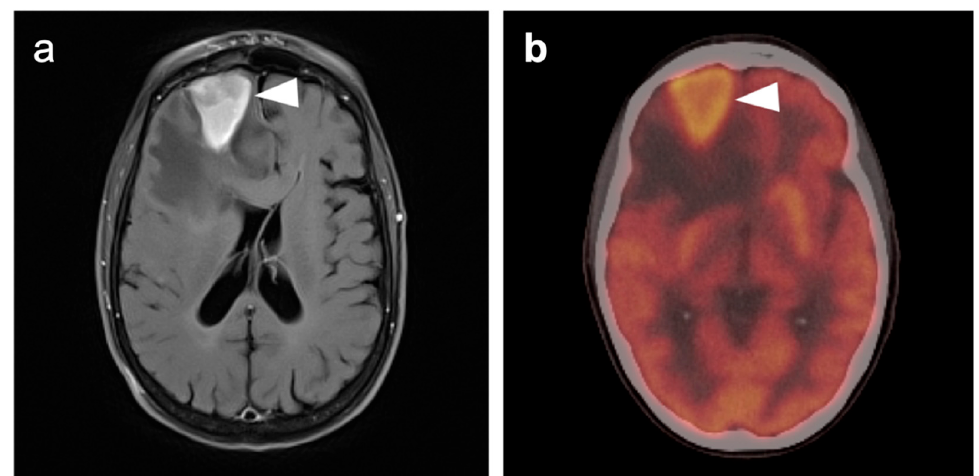
Figure 42. Primary CNS lymphoma. ( a ) Enhancing lesion in the right frontal lobe on axial contrast- enhanced Gad+ T1FS MRI, with surrounding edema and mass effect (arrowhead); ( b ) The lesion shows intense activity on axial fused FDG PET-CT (arrowhead). This was a biopsy-proven primary CNS lymphoma.